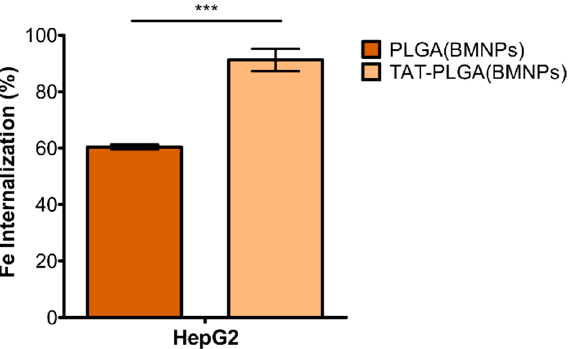
Figure 5. Internal iron content in the viable cells upon treatment with PLGA(BMNPs) and TAT– PLGA(BMNPs). Data represent the means ± SEM of three independent experiments performed in triplicate; p ≤ 0.001 (***).